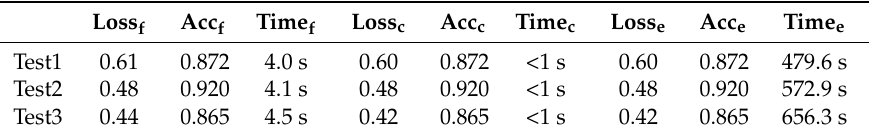
Table 4. Comparison of